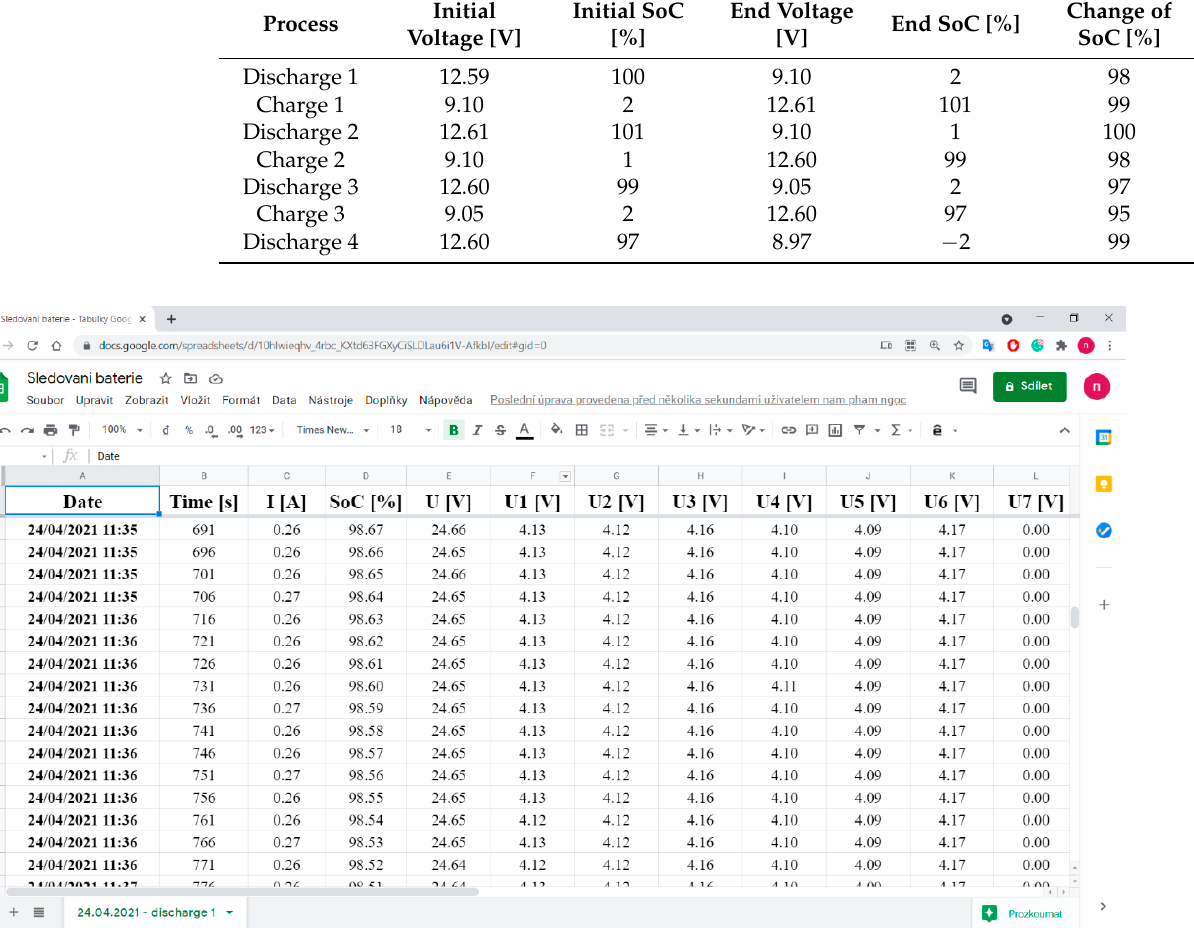
Figure 20. The data transmitted via IoT to Google